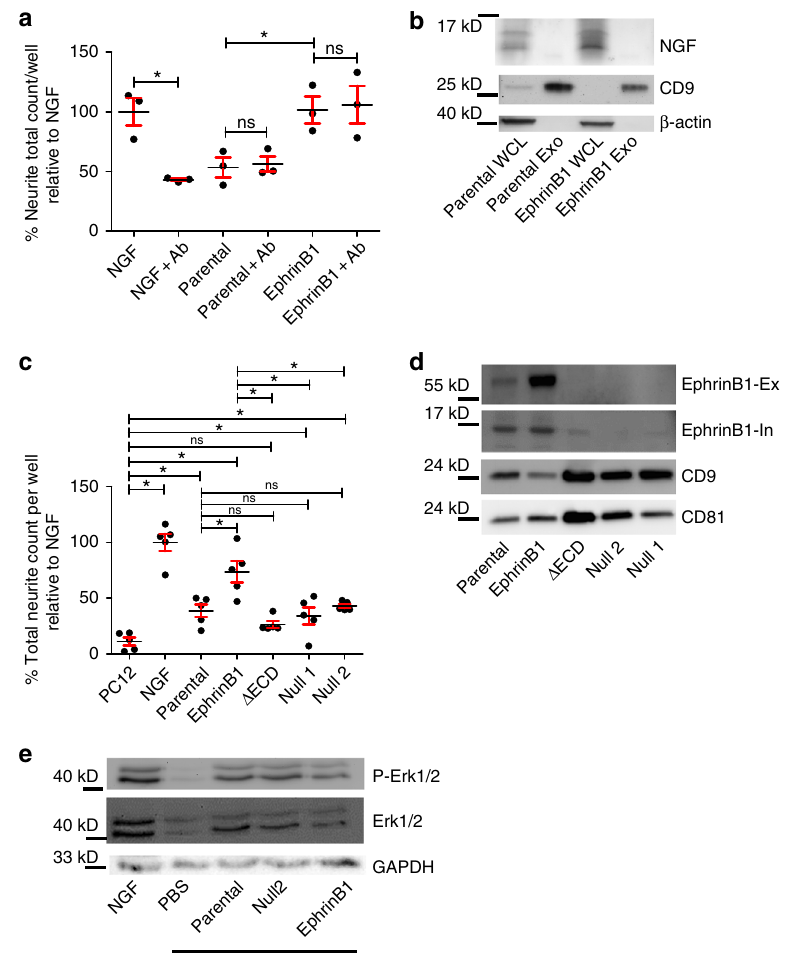
Fig. 6 mEERL exosomes induce neurite outgrowth without NGF. a PC12 cells were stimulated with 100 ng/ml of recombinant NGF (NGF), mEERL parental (parental) or mEERL EphrinB1 (EphrinB1) conditioned media with or without neutralizing anti-NGF antibody ( + Ab); 24 h later, cells were fi xed and stained for β -III tubulin expression which was then quanti fi ed. Statistical analysis by two-way ANOVA with post hoc Fisher ’ s Least Signi fi cant Difference (LSD) test. LSD p values reported; * p <0.006. ns, not signi fi cant. The variance between groups compared is similar. n = 3 technical replicates/condition; experiment repeated at least two times with biological replicates. Central value used was the mean. All comparisons and LSD p values found in Supplementary Table 4. b Western blot analysis of exosomes (Exo) or whole cell lysate (WCL) from the indicated mEERL cell lines. Western blot repeated at least n = 2 times with biological replicates. c Neurite outgrowth quanti fi cation of PC12 cells following exosome treatment from the indicated sources. Statistical analysis by one-way ANOVA with post hoc Fisher ’ s Least Signi fi cant Difference (LSD) test. LSD p values reported; * p <0.02; ns, not signi fi cant. n